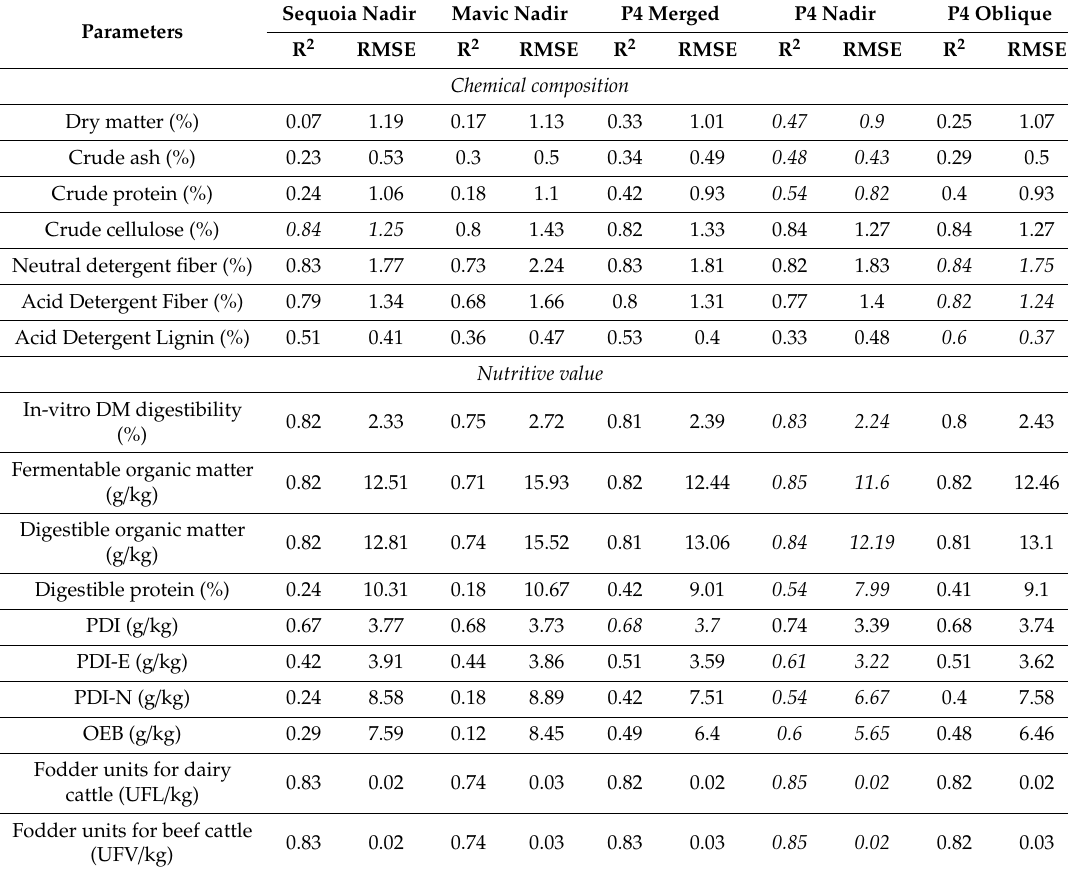
Table 4. Modeling the forage quality using five di ff erent UAS survey strategies. For each parameter, the best model’s accuracy values are